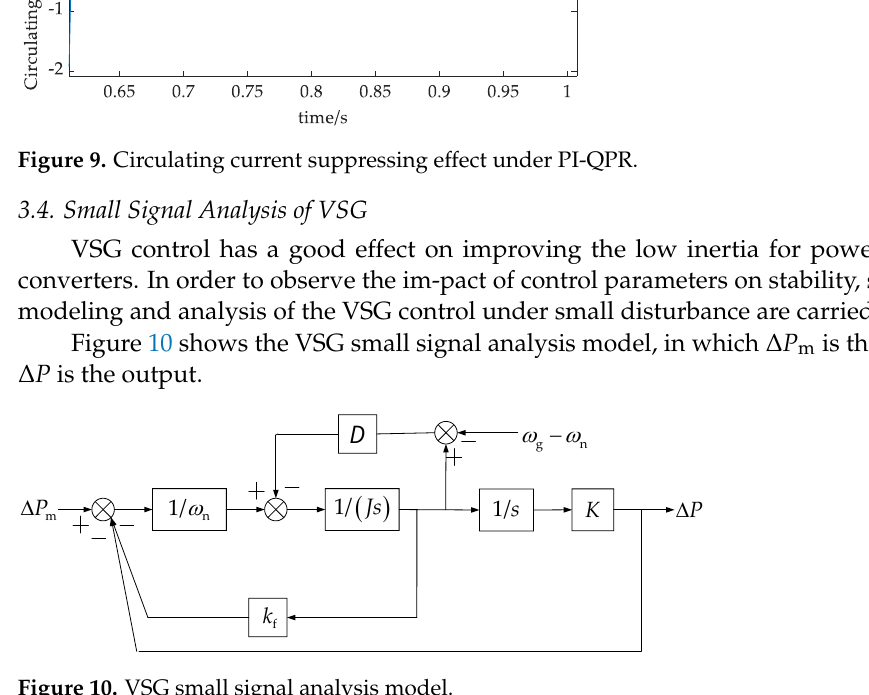
Figure 10. VSG small signal analysis model.